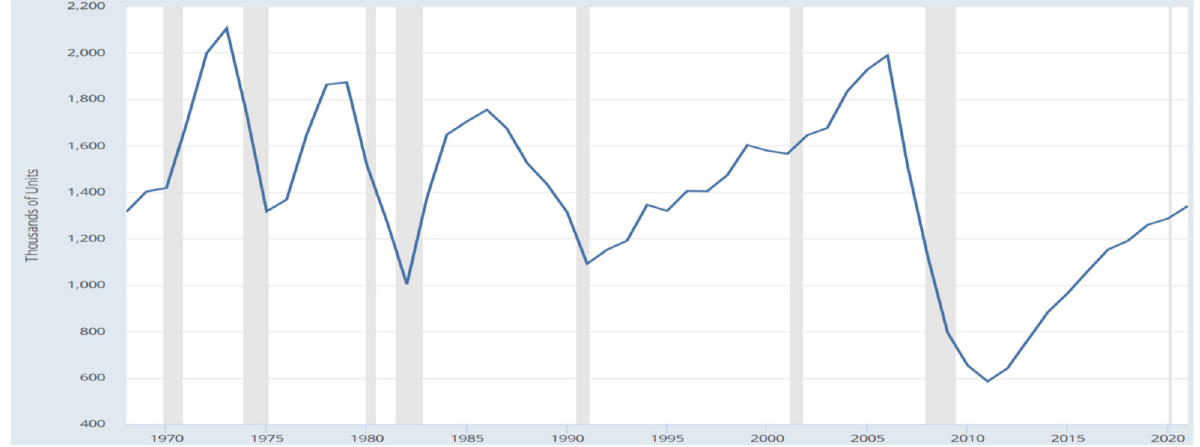
Figure 15. New Privately-Owned Housing Units Completed: Total Units. Source: Census; HUD.